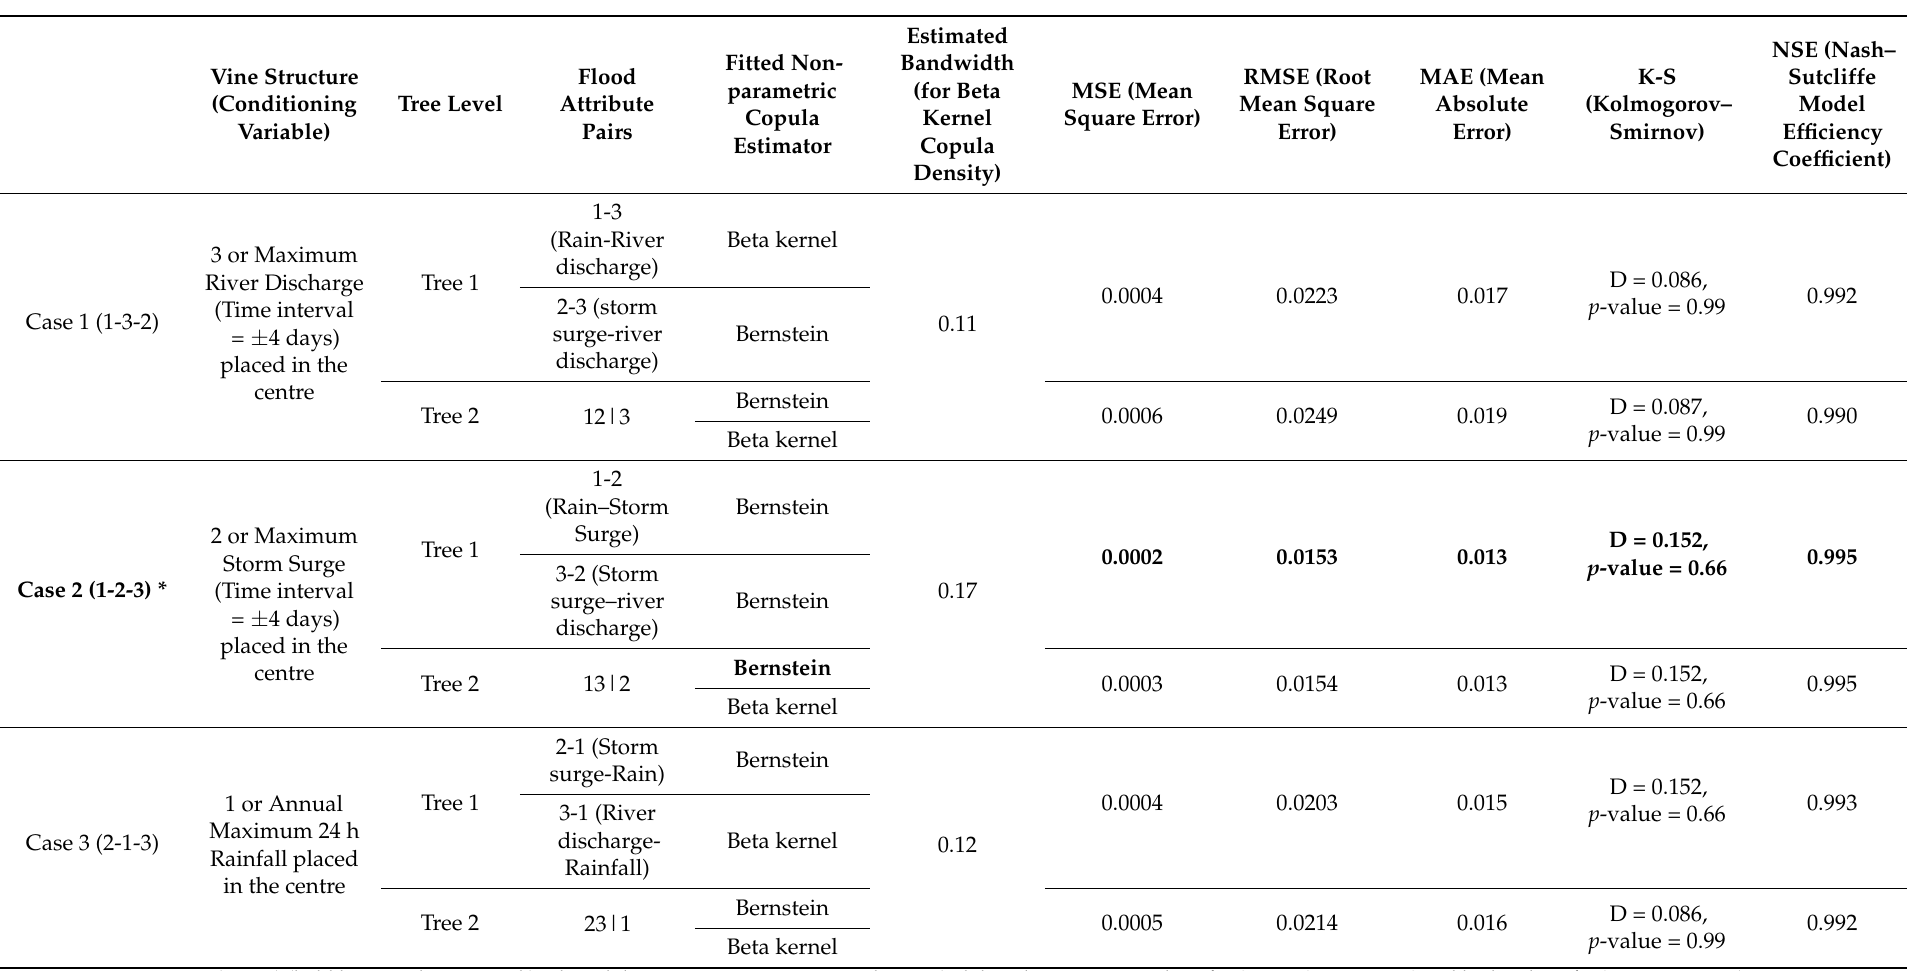
Table 4. Summary statistics in the nonparametric D-vine structure for three different cases by incorporating the Bernstein estimator and Beta kernel density (each D-vine structure is defined by permutating the location of the conditioning